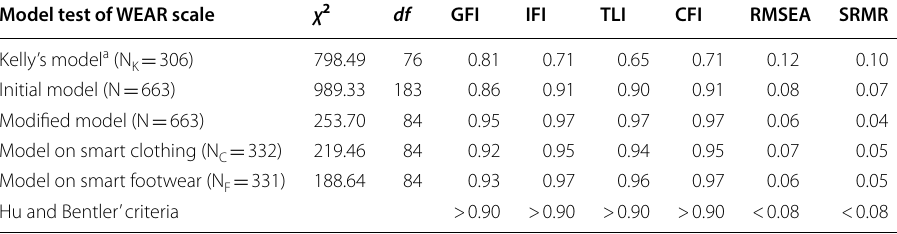
N , total sample size; N C , sample size of smart clothing; N F , sample size of smart footwear; χ 2 , Chi square; df , degree of freedom; GFI, goodness fit index; IFL, incremental fit index; TLI, Turker–Lewis index; CFI, comparative fit index; RMSEA, root mean error of approximation; SRMR, standardized root mean square residual a Result of the model fit for Kelly’s (2016) 14-item WEAR